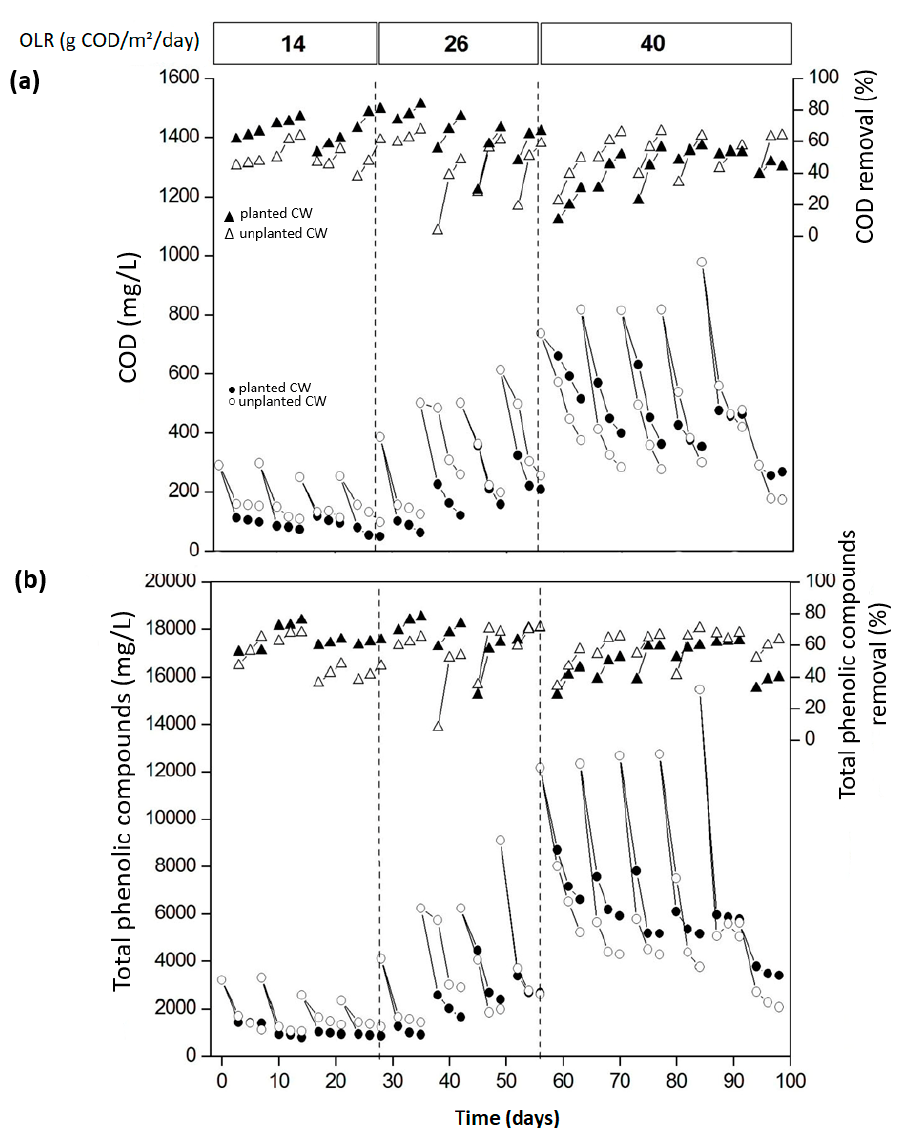
Figure 5. Variations of ( a ) effluent COD and ( b ) effluent total phenolic compounds concentration and respective removal rates in the planted and unplanted CW treating E. globulus leachate.